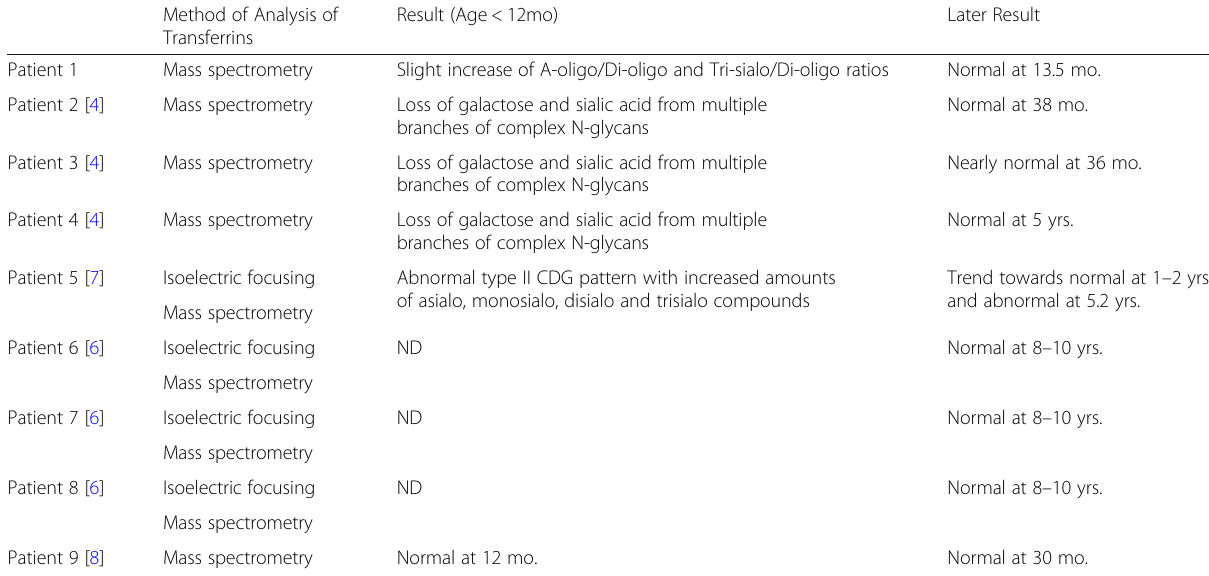
Table 2 Serum Transferrin in SLC35A2-CDG